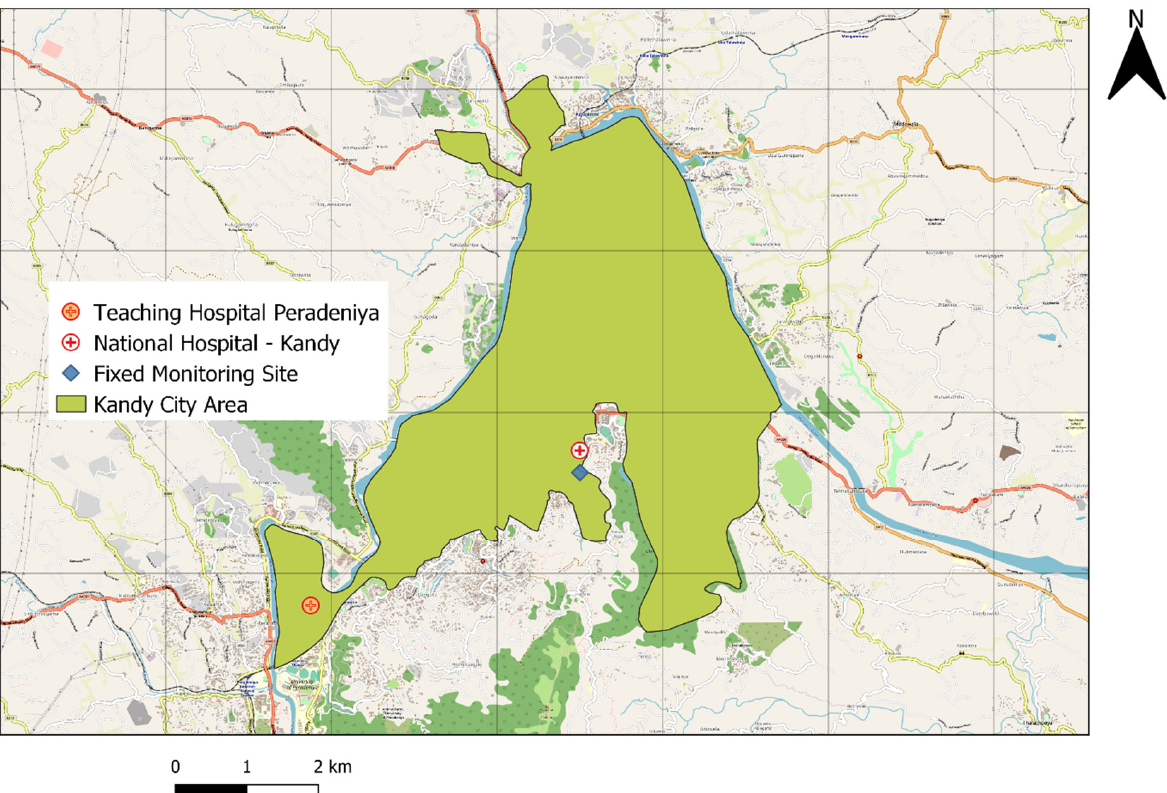
Figure 1. The locations of the air monitoring site and hospitals in Kandy.